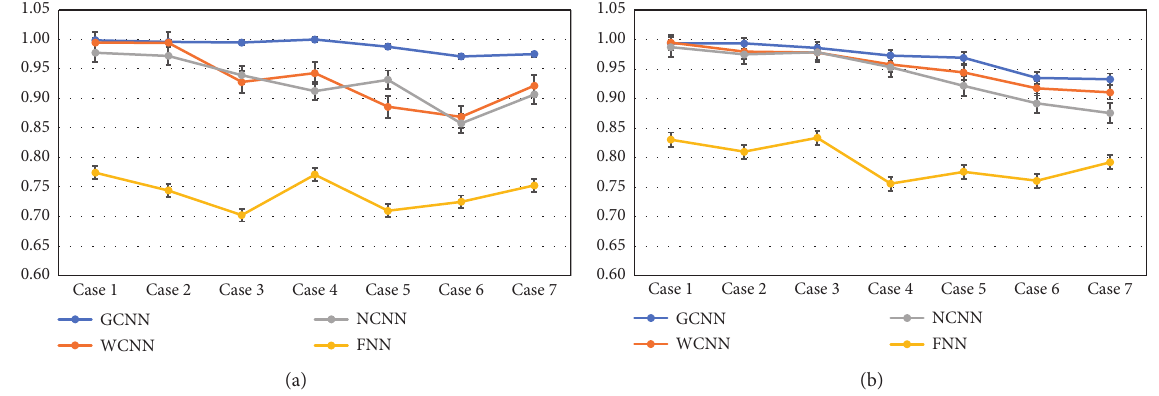
Figure 16: AUC of seven cases. (a) Four classes and (b) sixteen